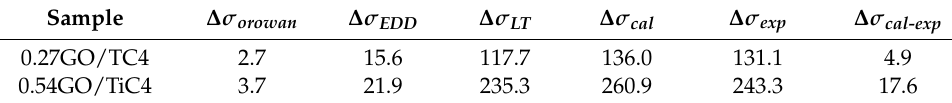
Table 2. Strengthening contributions of GO/TC4 composites (MPa).